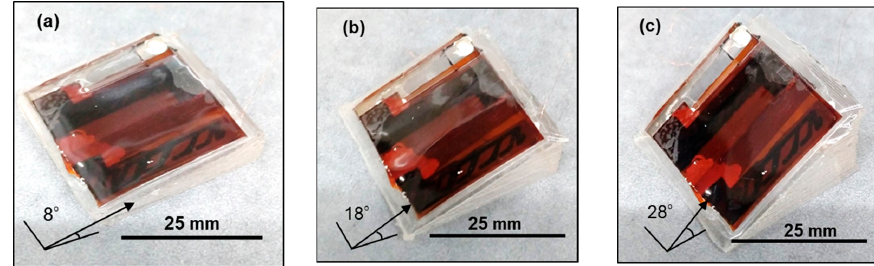
Figure 2. Photographs of typical slope-type thin-film thermoelectric generators with slope angles of ( a ) 8°, ( b ) 18°, and ( c ) 28°.